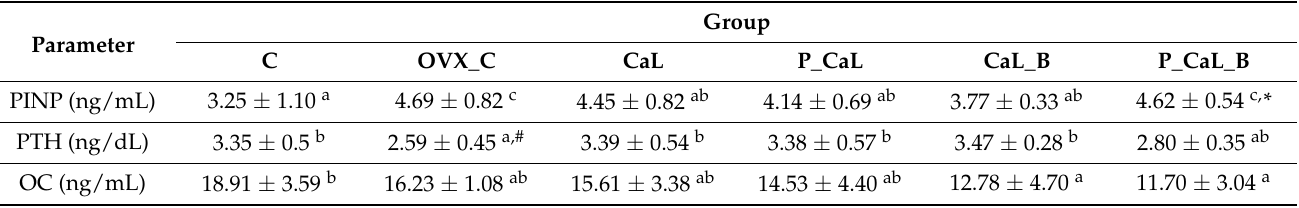
Table 5. Parameters of calcium and bone metabolism in serum of rats (mean and standard